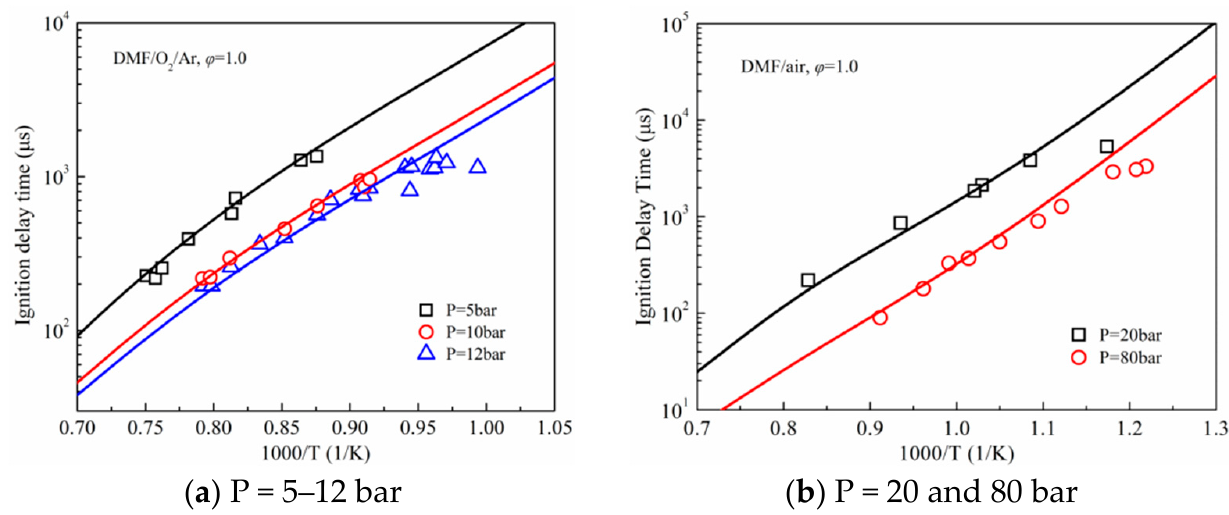
Figure 5. Comparisons between the predicted (lines) and experimental [42,43] (symbols) ignition delays of DMF.